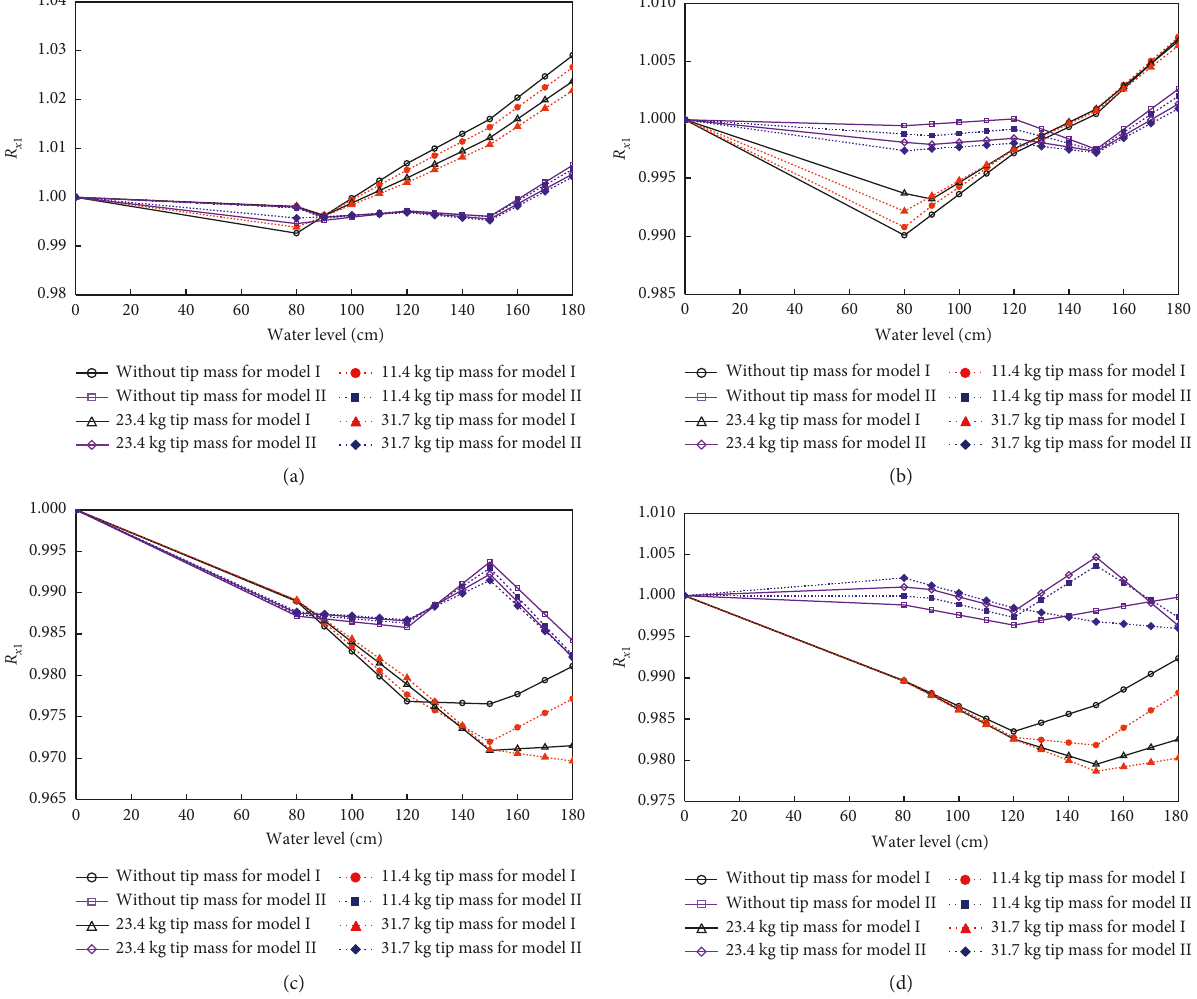
Figure 20: Vibration period ratios of the specimen in case III as a function of water level correspond to: (a) first mode along the x -axis; (b) first mode along the y -axis; (c) second mode along the x -axis; and (d) second mode along the y